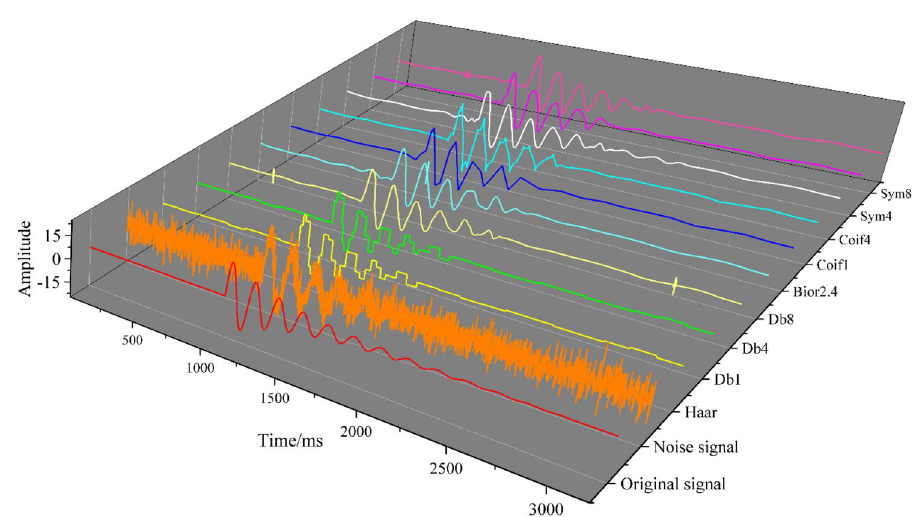
Figure 7. Denoising results for different wavelet basis functions.